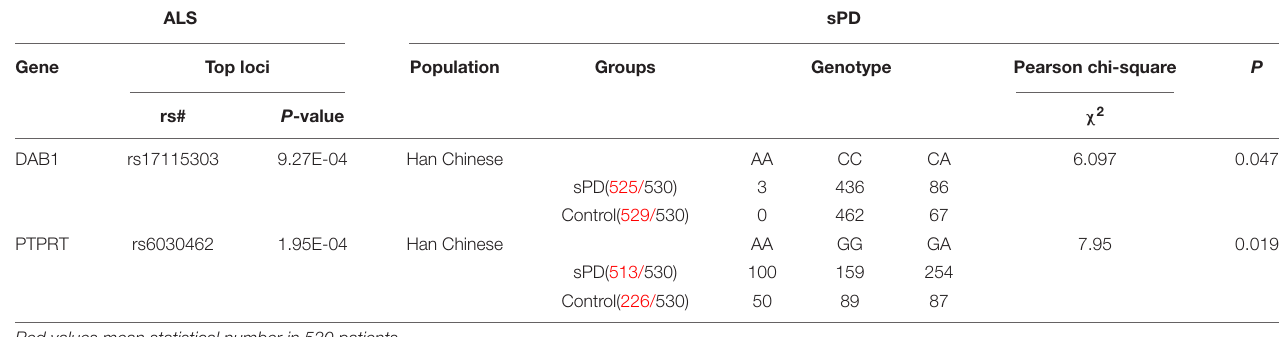
TABLE 2 | Verified loci in Chinese Han populations of mainland.